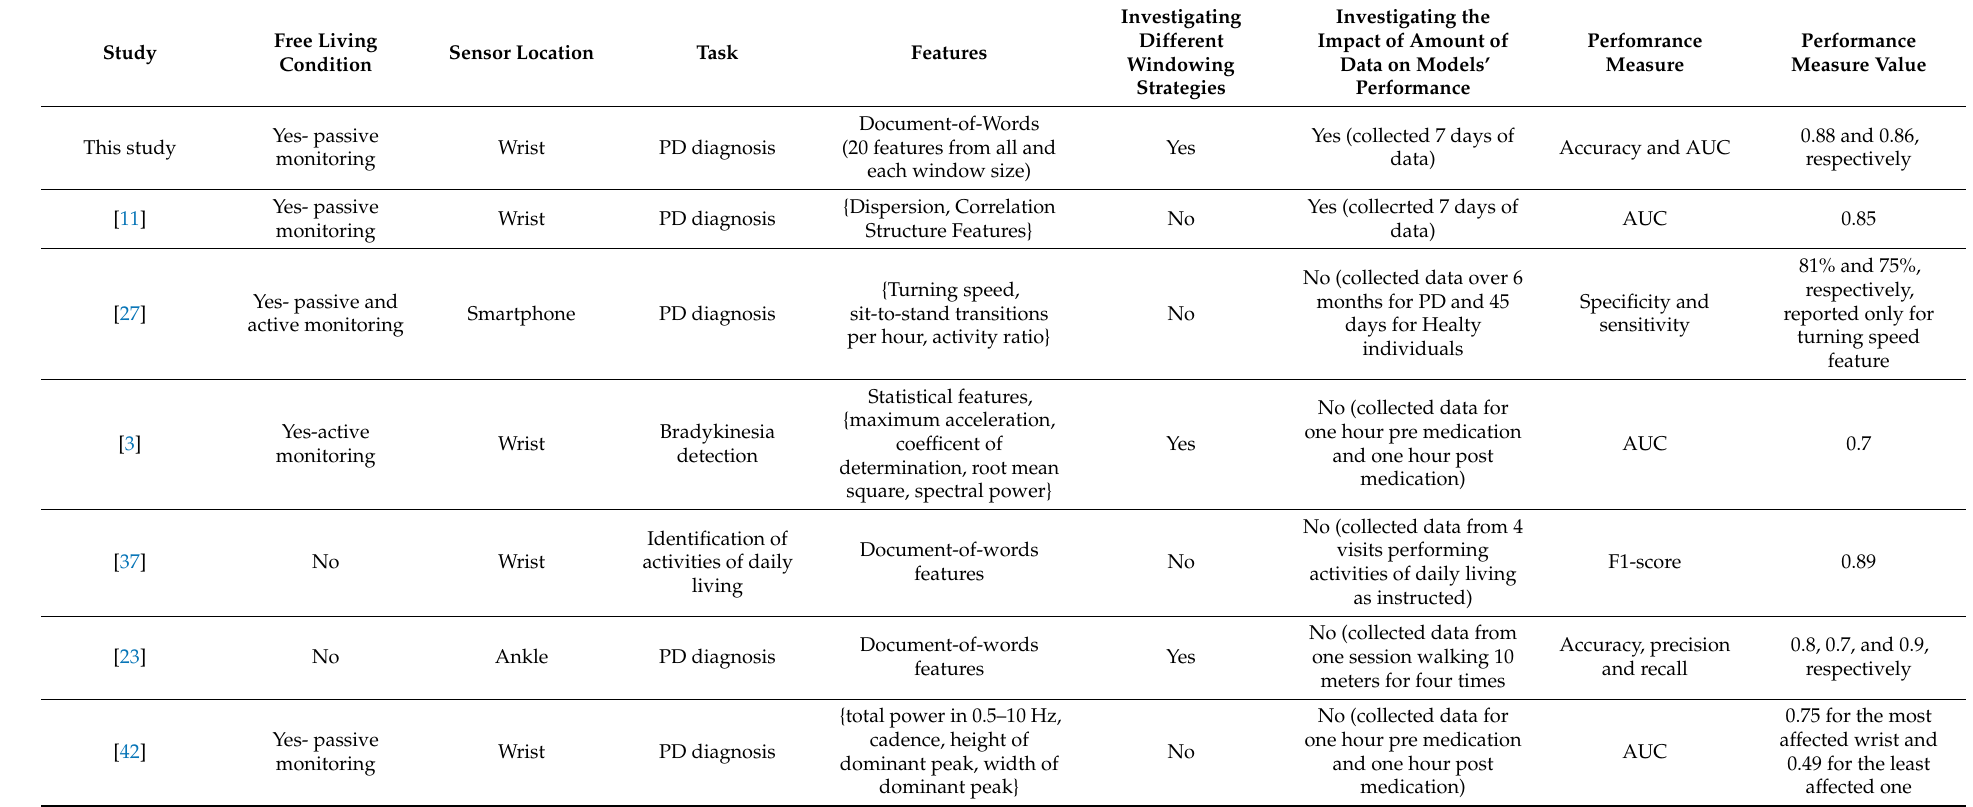
Table 5. Related Works with a Focus on Similarities and Differences between them and our